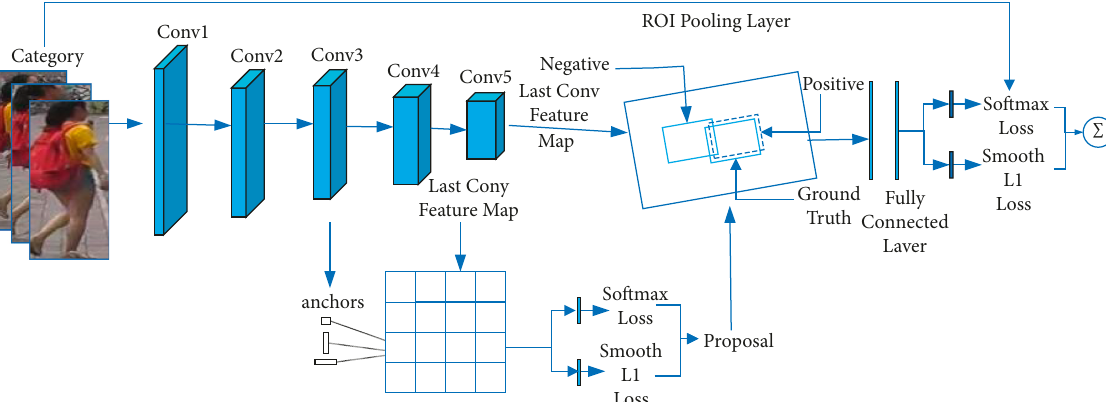
Figure 1: Component detection algorithm flow.